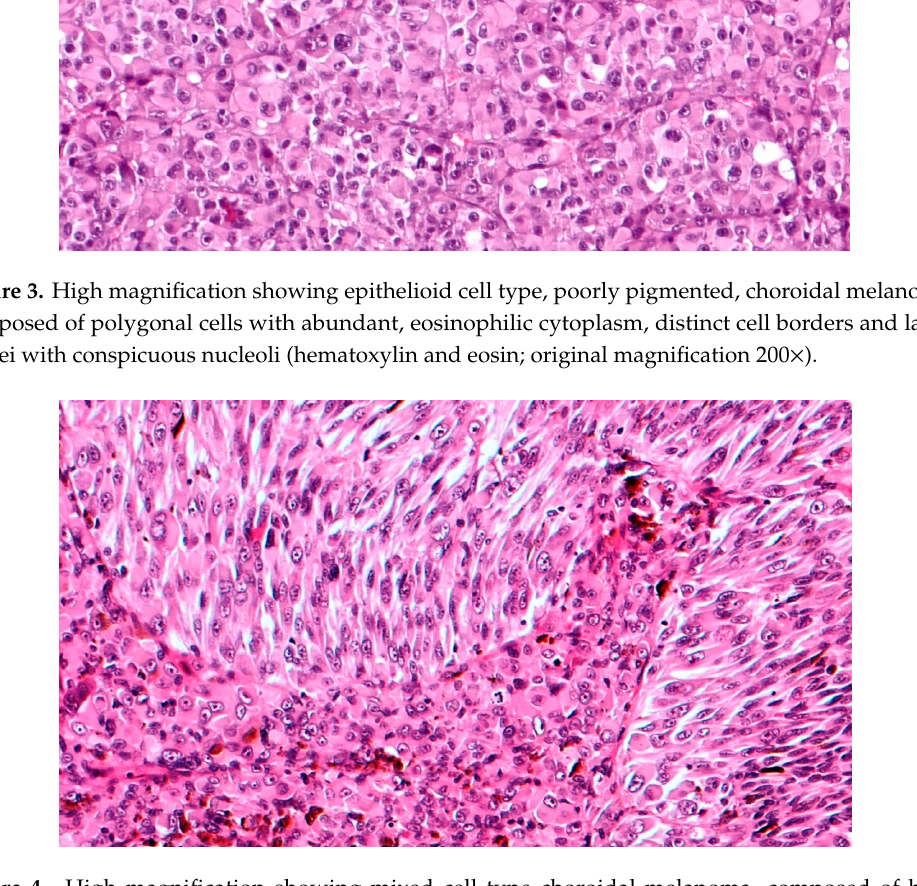
Figure 5. Intermediate magnification showing epithelioid cell type choroidal melanoma with sparse chronic lymphocytic infiltrates (arrows) intermingled to neoplastic cells (hematoxylin and eosin; original magnification 100×). 4. Immunohistochemical Features CMs are positive for Human Melanoma Black 45 (HMB45) antigen, S-100 protein, Melan-A (also known as melanoma antigen recognized by T cells 1/MART-1), melanocyte inducing transcription factor (MITF), tyrosinase, vimentin, and Sex determining Region Y-Box 10 (SOX10) [15,16]. Differently to the strong labeling of cutaneous melanoma, S100 is frequently weak and variable in CM. HMB45 antigen, tyrosinase, Melan-A, SOX10 and MITF are better immunomarkers for CM considering the strong positivity in all histologic types [17]. Particularly, SOX10 is a nuclear transcription factor with crucial functions in the specification of the neural crest and maintenance of Schwann cells and melanocytes [18,19]. It is usually immunoexpressed at the nuclear level in melanocytes and breast myoepithelial cells and is currently used in the histopathologic diagnosis of many neoplasms, being diffusely positive in breast basal-like (triple-negative) carcinomas,